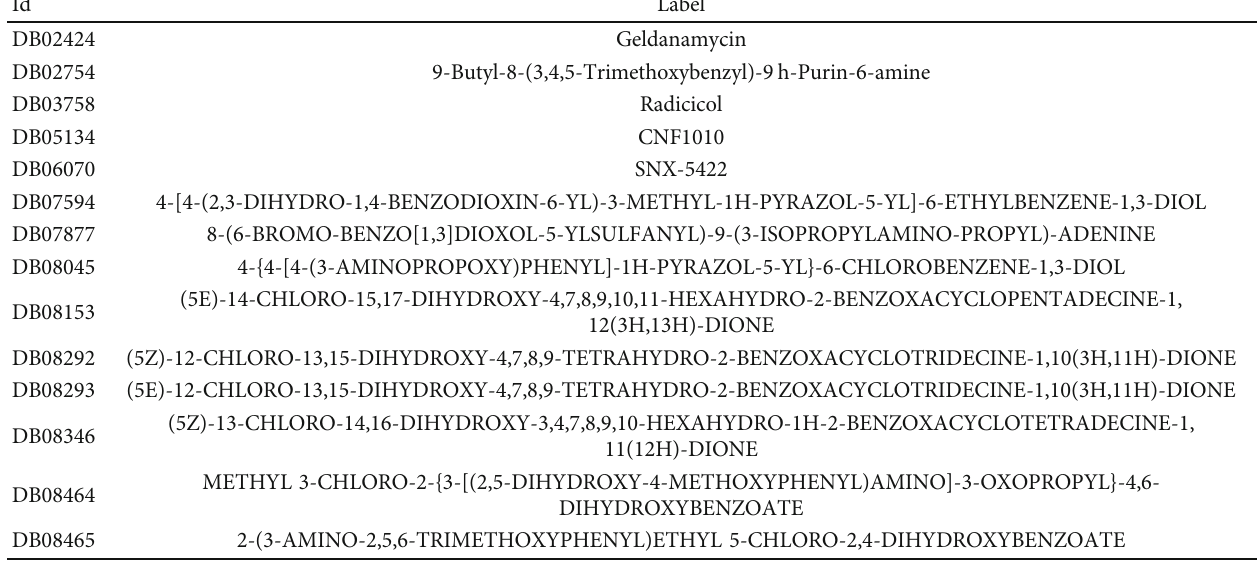
Table 2: Drugs with potential targeting of HSP90AB1 gene in DrugBank.